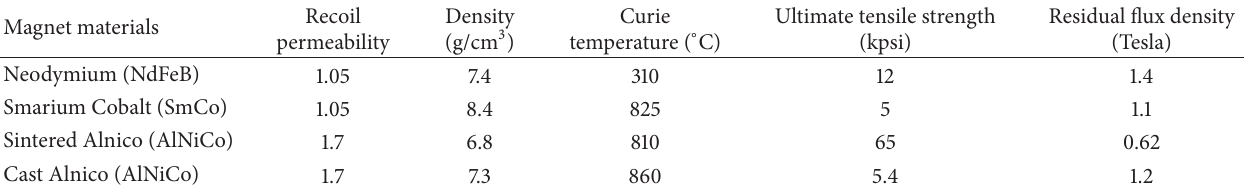
Table 5: Properties of permanent magnets used in EM-VEHs.